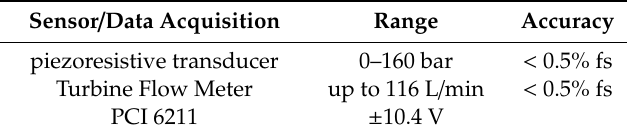
Table 1. Characteristics of measuring